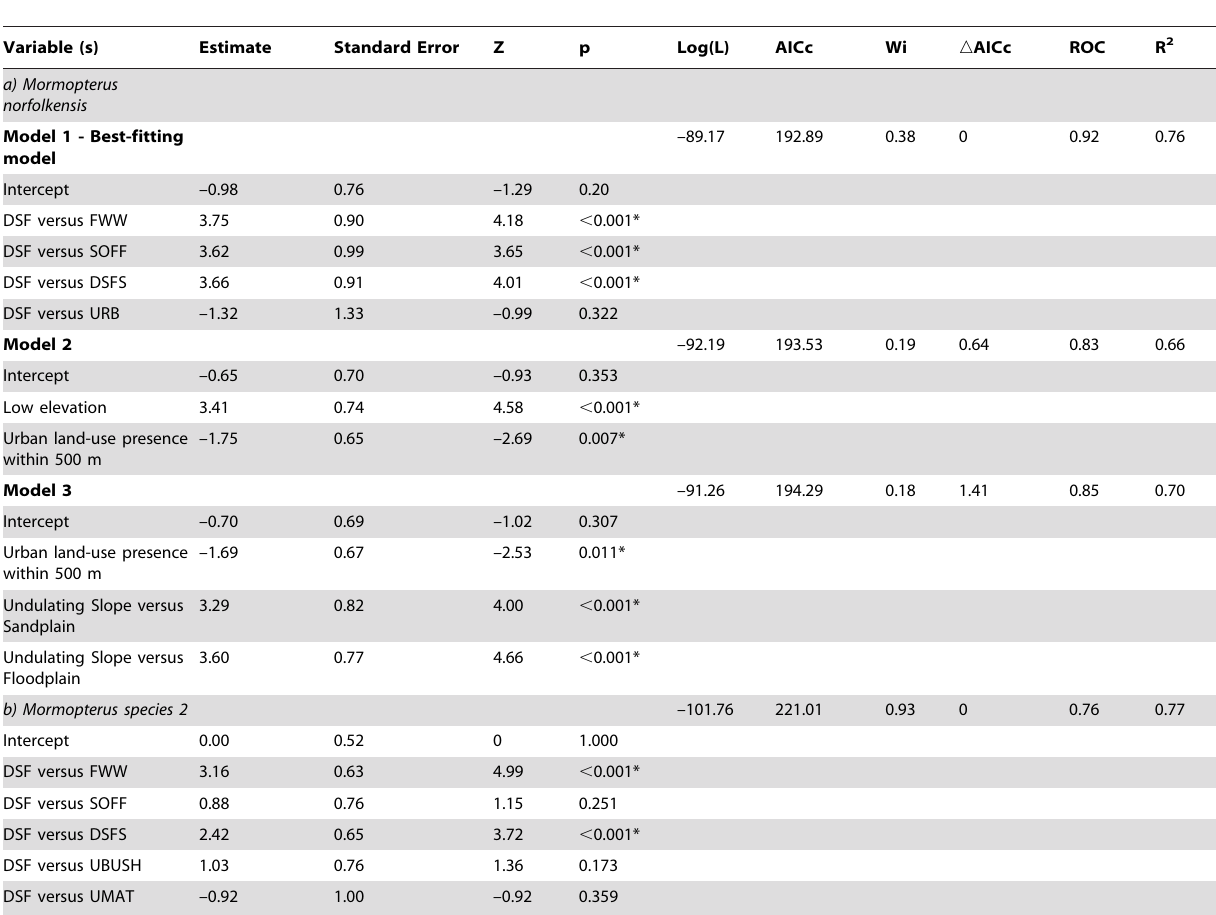
Table 1. Summary from habitat analysis of a) Mormopterus norfolkensis and b) M . species 2 surrounding a large M. norfolkensis maternity